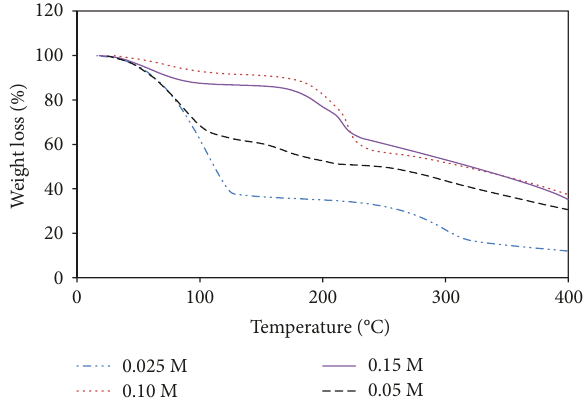
Figure 10: TGA results with di ff erent ferric chloride concentrations (pyrrole 0.05M and surfactant 0.025M at 25 ° C and duration of 4h).